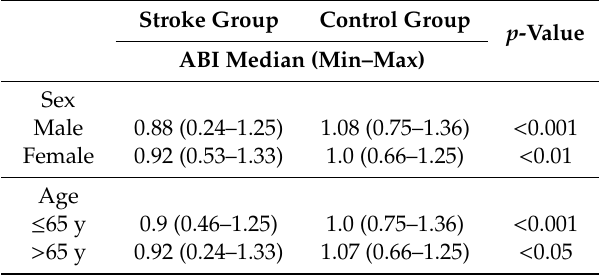
Table 5. ABI values in relation to sex and age in both groups.